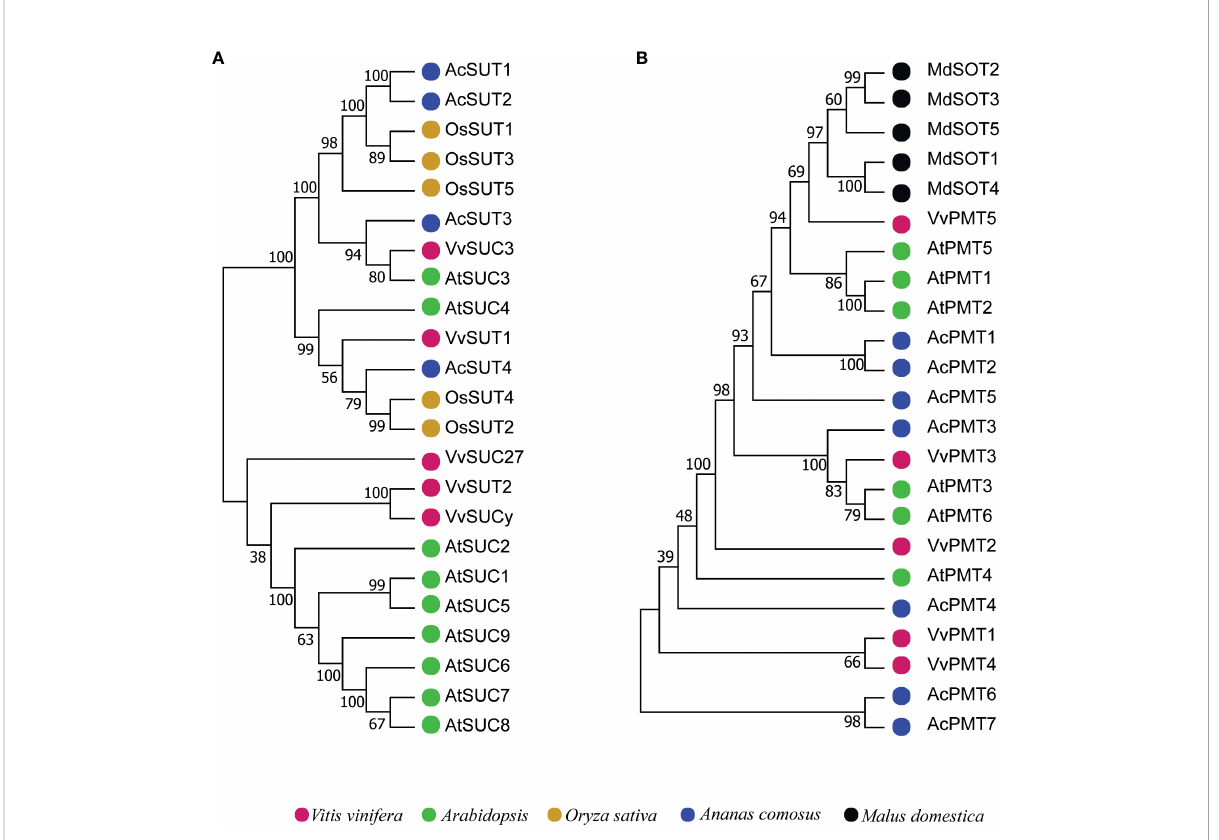
FIGURE 5 Phylogenetic tree of sugar transporters subfamilies among representative monocots and eudicots. The trees were built with the neighbor- joining algorithm using protein sequences. (A) The phylogenetic tree of the SUC/SUT subfamily. (B) The phylogenetic tree of the PMT subfamily. Sugar transporters genes of pineapple in the phylogenetic trees are marked with blue, and the sugar transporters genes of other species are marked with different colors as labeled at the